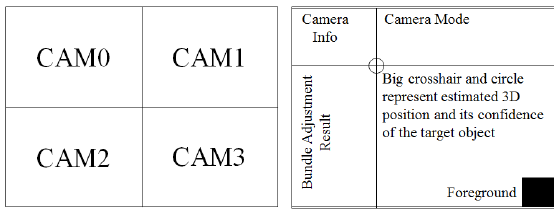
Figure 5. Legend for the screenshots; Camera ID (left) and information on a single camera screen (right)